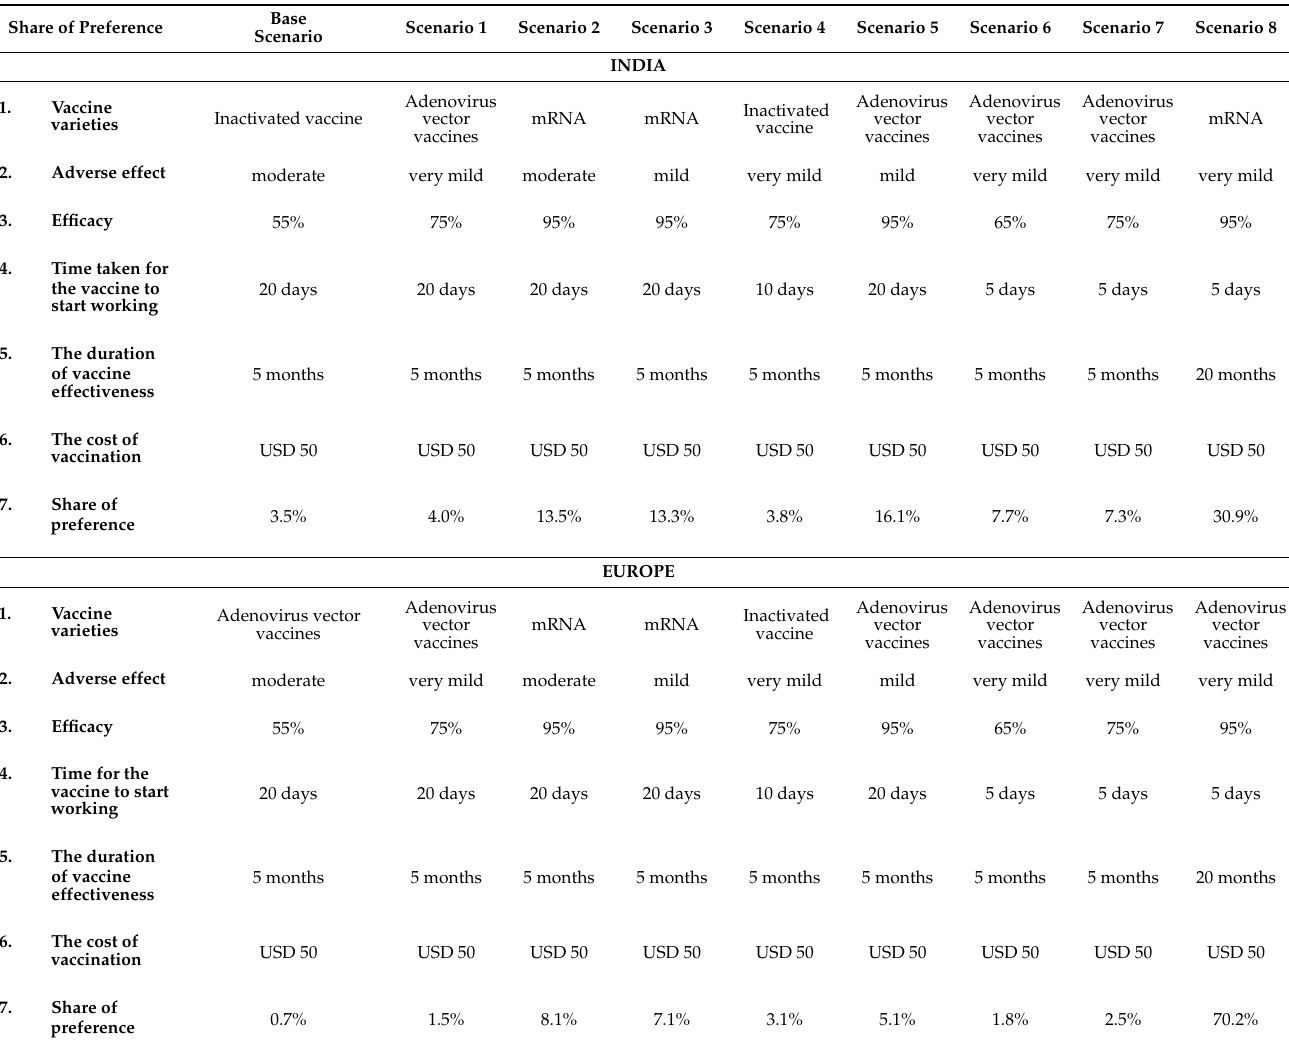
Table 4. Share of preference and scenario analysis